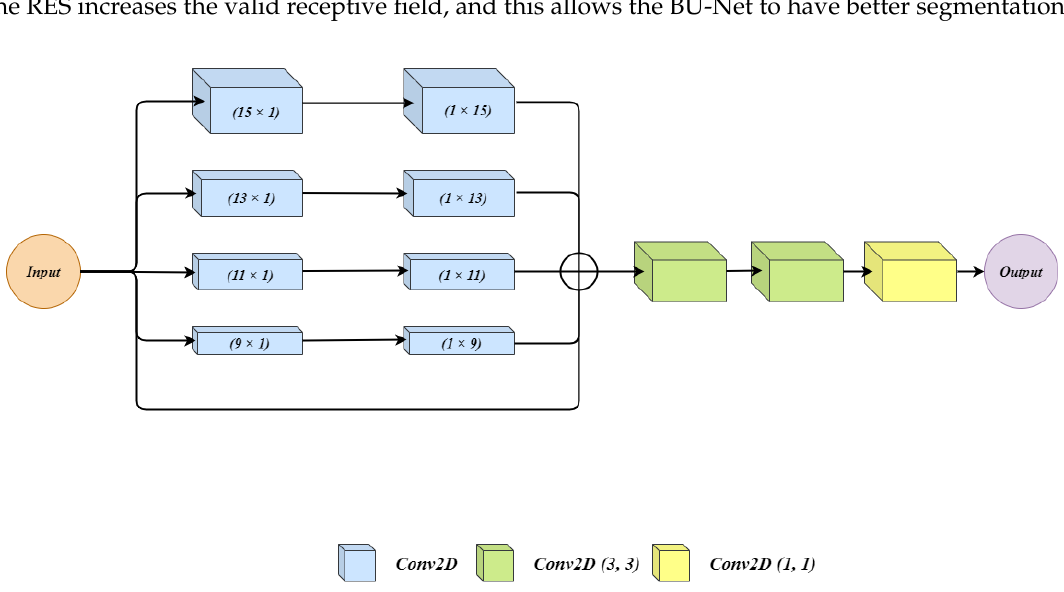
Figure 3. The architecture for Residual Extended Skip (RES) block.